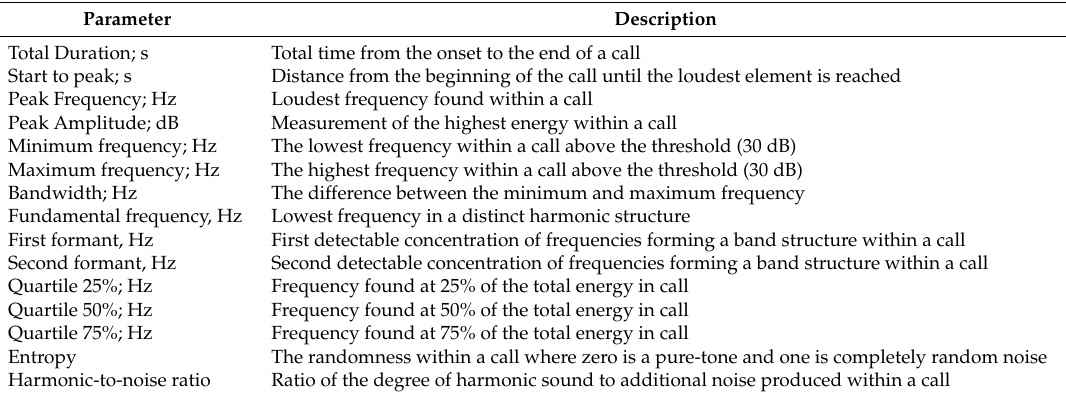
Table 1. Parameters measured on piglet calls produced during manual restraint by a human or during crushing by sows during the first 48 h of